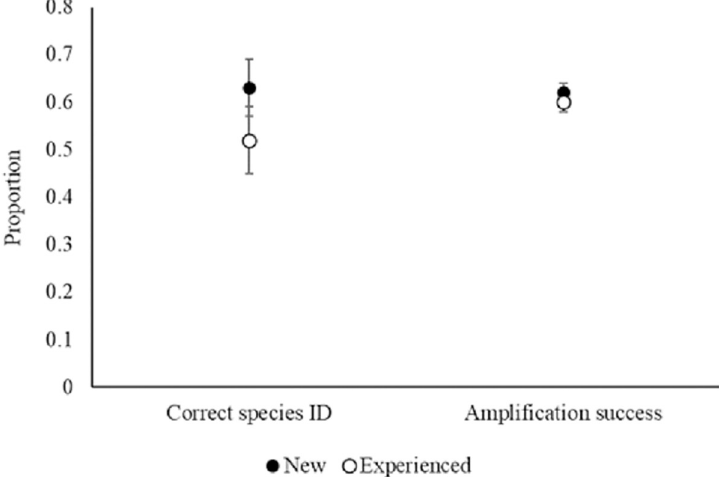
Fig 2. Proportions of rendezvous site fecal samples that successfully amplified and proportions of incidental fecal samples that were correctly identified in the field as wolf as a function of observer experience level (n = 58), during genetic surveys in Alberta, Canada, central Idaho, and Yellowstone National Park, WY, USA, 2008–2014. Error bars represent the